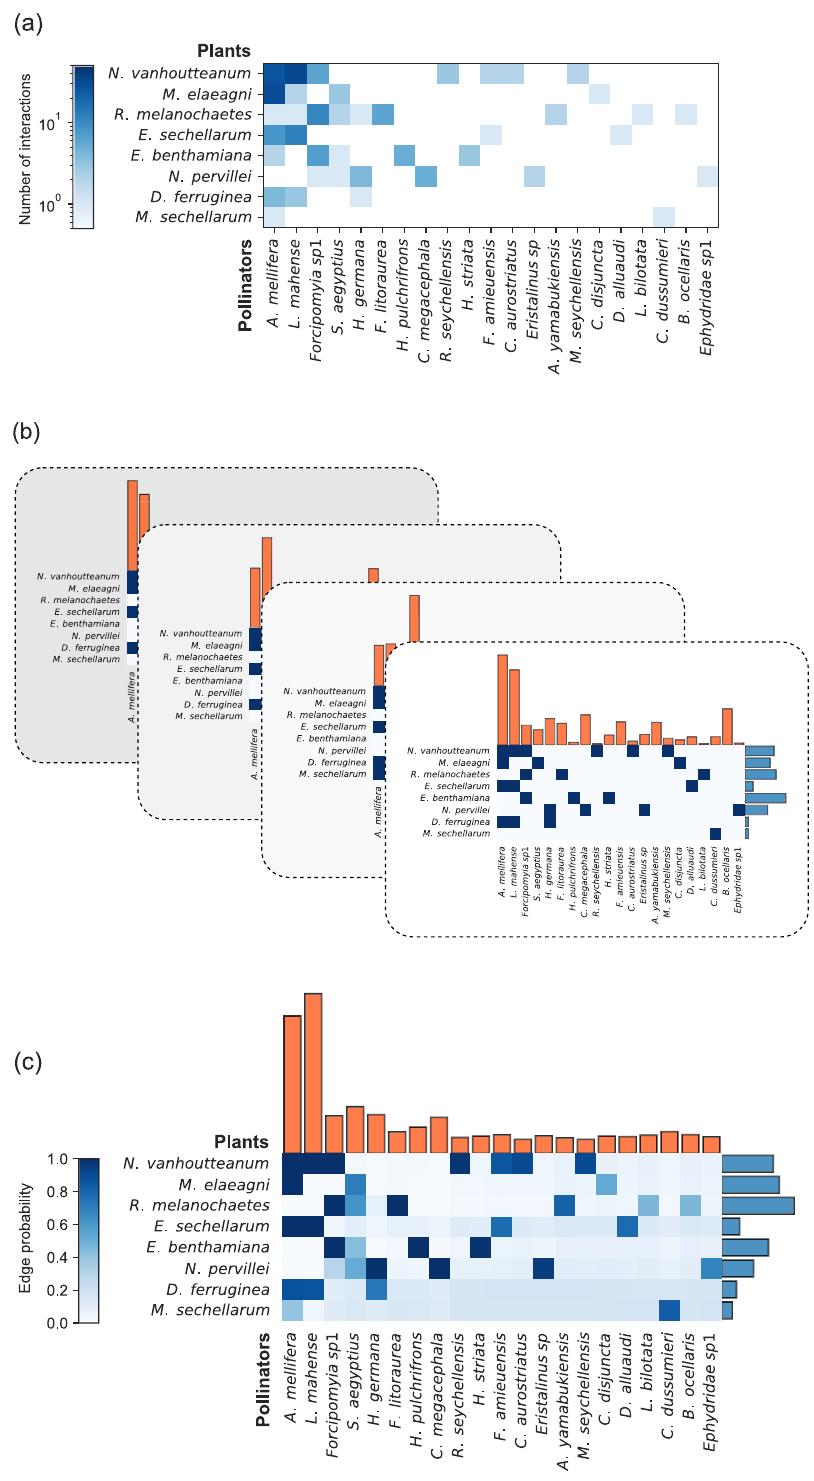
Fig. 1 Illustration of the method of this paper applied to data from the study of Kaiser-Bunbury et al. 41 . a We start with a data matrix M that records the number of interactions between each plant species and pollinator species. Species pairs that are never observed to interact ( M ij = 0) are shown in white. b We then draw 2000 samples from the distribution of Eq. (5), four of which are shown in the fi gure. Each sample consists of a binary incidence matrix B , values for the relative abundances σ and τ (shown as the orange and blue bar plots, respectively), and values for the parameters C , r , and ρ (not shown). c We combine the samples using Eqs. (7) – (9) to give an estimate of the probability of each edge in the network and the complete parameter set θ . For the data set studied here our estimates of the expected values of the parameters C , r , and ρ are 〈 C 〉 = 20.2, 〈 r 〉 = 45.9, and 〈 ρ 〉 =